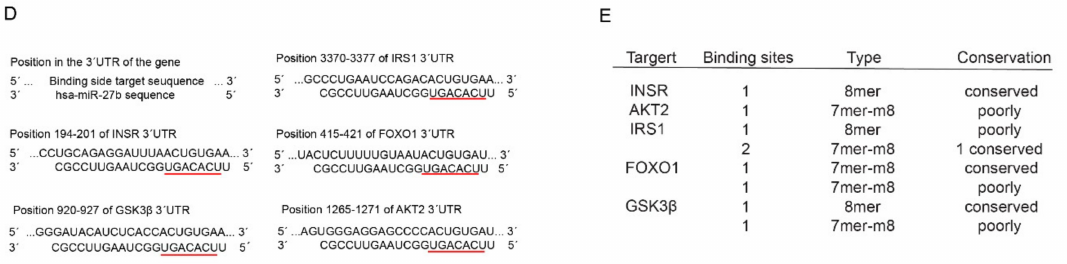
Figure1. miR-27bispredictedtotargetmanygenesinvolvedininsulinsignalingpathway. ( A )schematic representation of miR-27b genomic location; ( B ) pathway enrichment of validated targets of miR-27b; ( C ) interaction gene sequences of the five genes selected in this study with miR-27b; ( D ) genetic representation of miR-27b interactions with the 3 0 UTR of the selected genes; and ( E ) number, type and conservation of predicted sites of the selected genes.